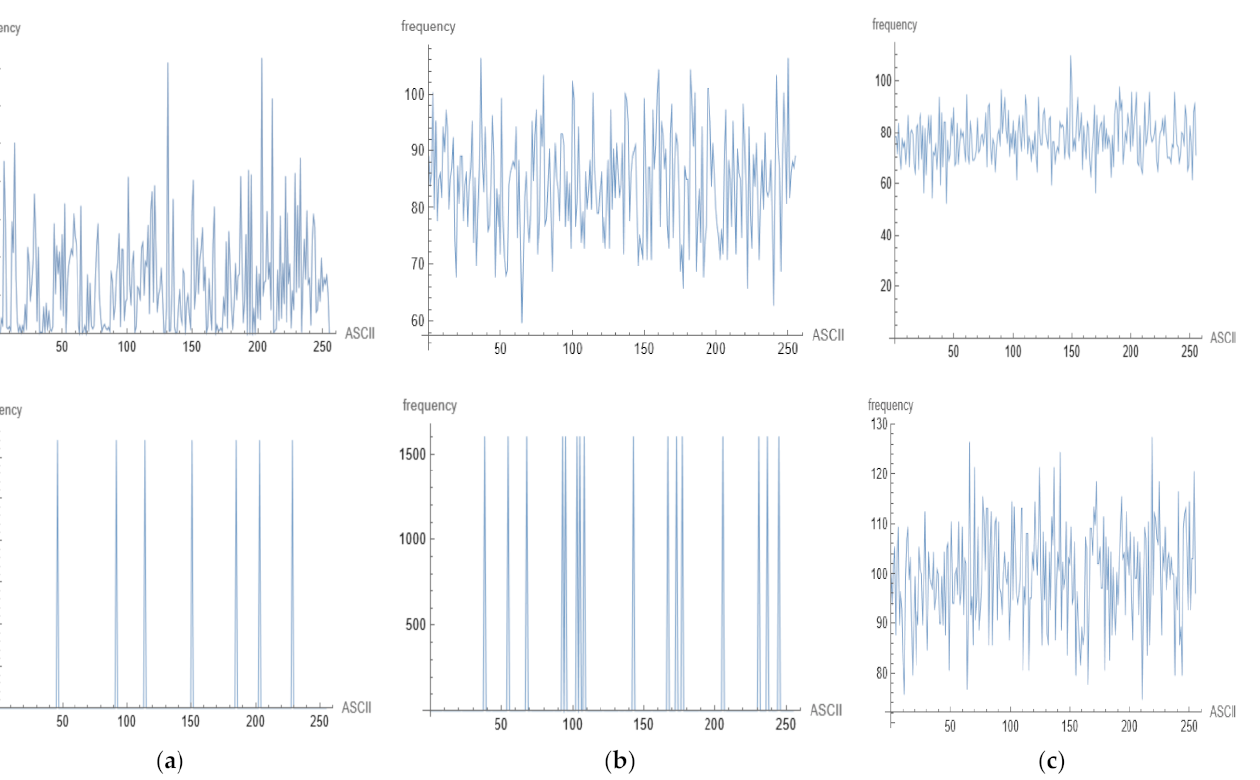
Figure 8. Plaintext statistics ( a ) Plaint text statistics and repeated letters in plaintext, ( b ) Statistics of MARS, and ( c ) Statistics of proposed